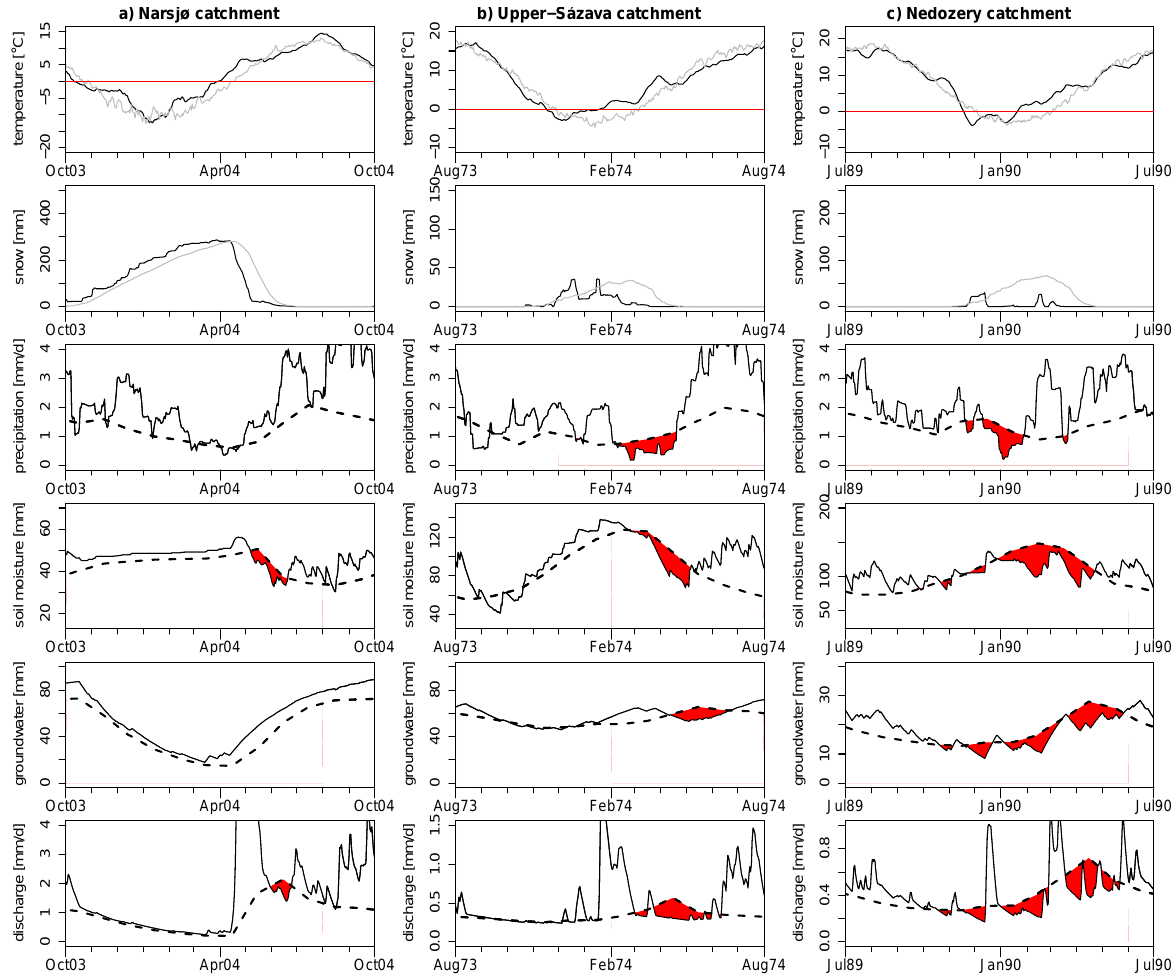
Fig. 9. Examples of warm snow season drought type: (a) Narsjø catchment 2003–2004, (b) Upper-S´azava catchment 1973–1974, (c) Nedoˇzery catchment 1989–1990 (legend: see Fig.